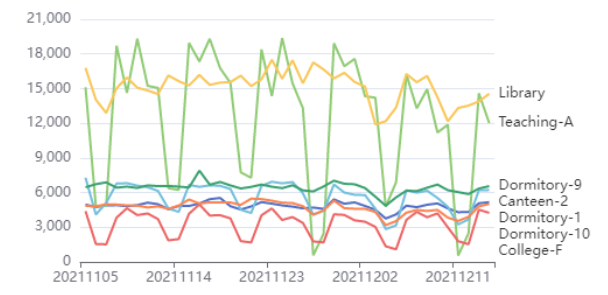
Figure 6 . Timing Characteristics(day).